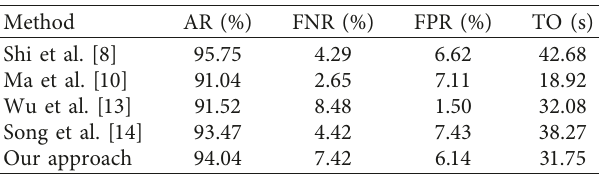
Figure 6: Threshold D effect on (a) false negative rate curve and (b) false positive rate curve. Table 6: The performance comparison between our approach and methods in [8, 10, 13,